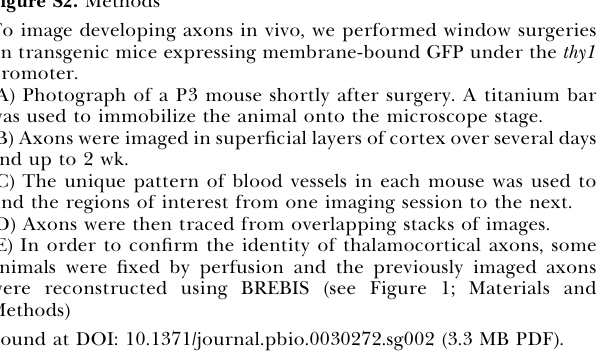
Figure S2. Methods